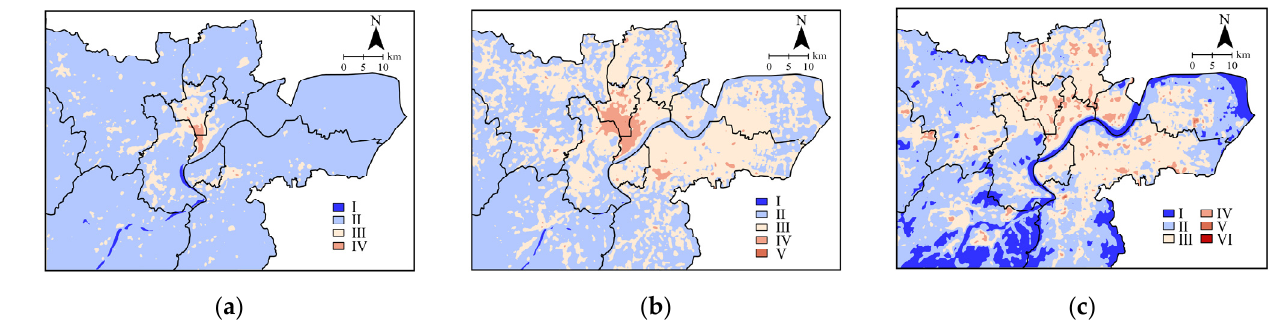
Figure 9. Distribution and influence of Hangzhou’s high temperature on negative emotions during the three periods in the daytime: ( a ) 1984; ( b ) 1998; ( c ) 2020.